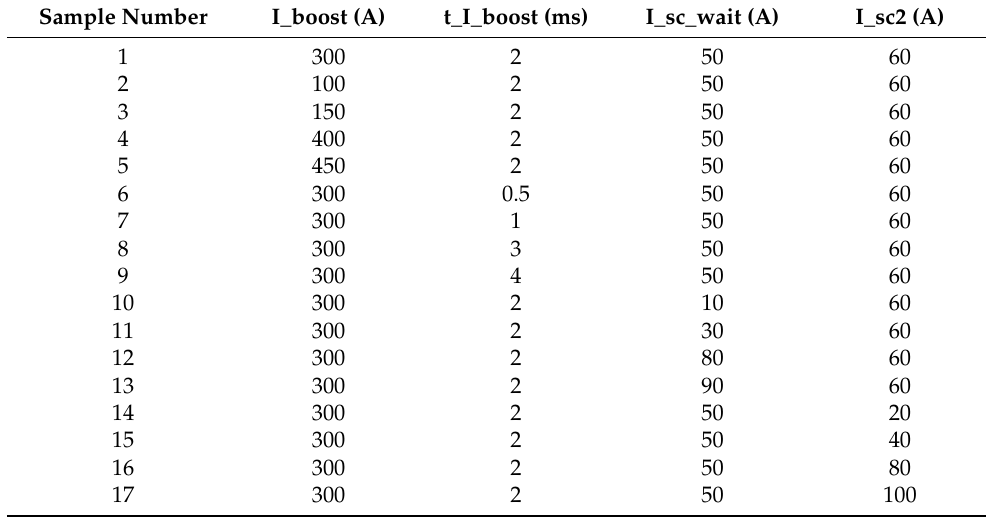
Table 2. CMT characteristic parameters for the swing arc deposition of Mg